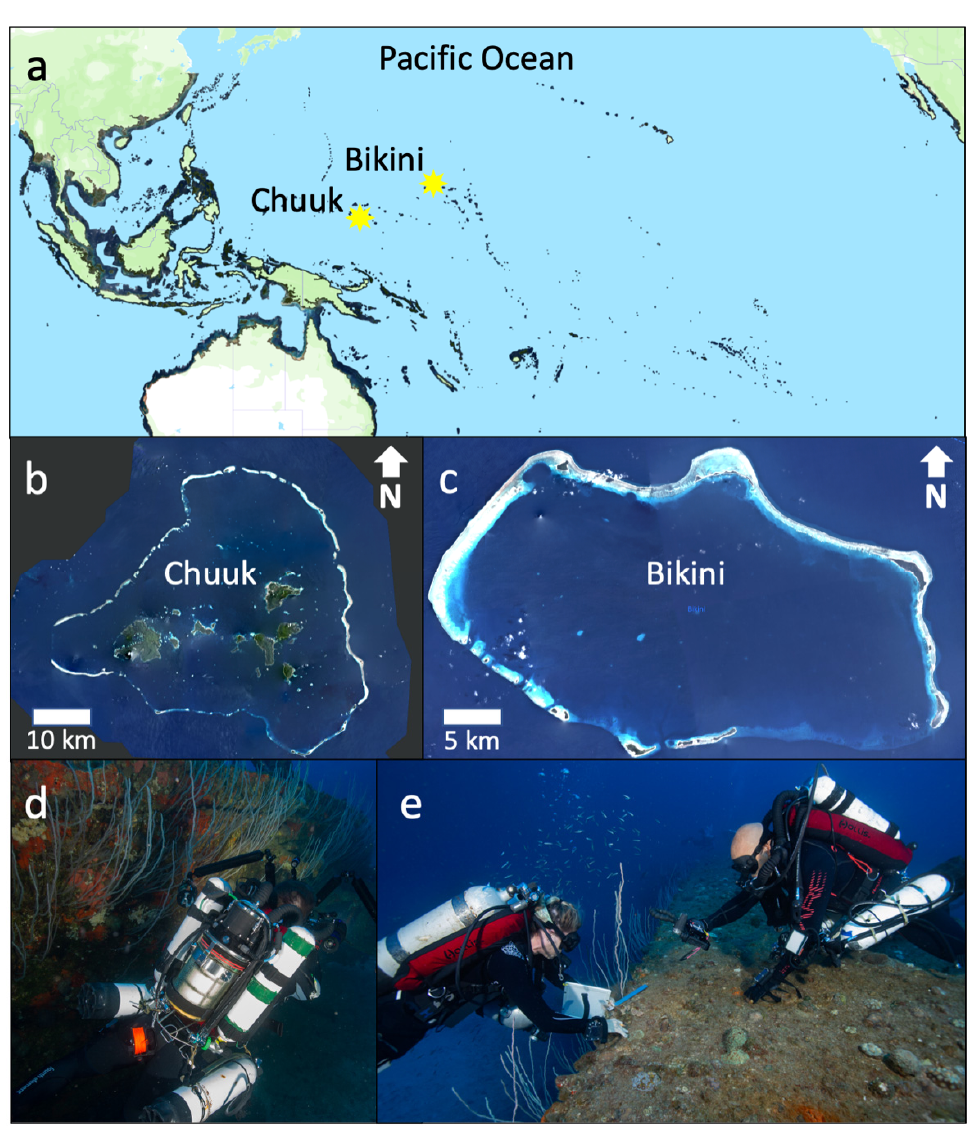
Figure 1. ( a ) Location of Chuuk and Bikini Atolls in the western Pacific. Background image indicates coral reefs in dark colors from the Allen Coral Atlas (http://allencoralatlas.org, accessed on 15 December 2021). ( b , c ) Planet Dove satellite images of Chuuk and Bikini Atolls. ( d ) Example hull video transect collected using high-resolution camera, lights, and closed-circuit rebreather. ( e ) Technical divers collecting detailed measurements and photographs for a shipboard coral genus database.